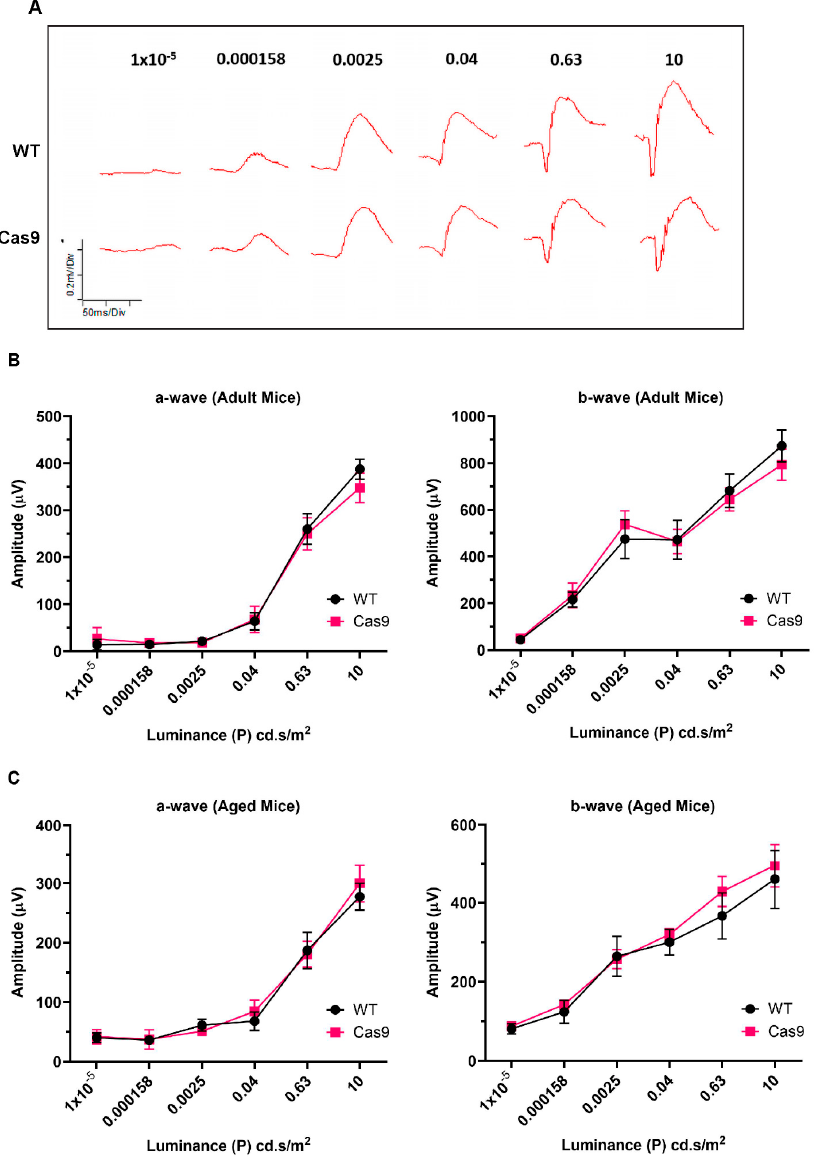
Figure 4. ERG analysis of retina function in Cas9 mice ( A ) Representative waveforms from ERGs of adult WT and Cas9 mice. ( B , C ) Scotopic a- and b-wave amplitudes, respectively, of adult and aged WT and Cas9 mice as a function of light intensity. Error bars represent SD (n = 6–8 per group). The a-wave and b-wave amplitudes at different flash intensities did not show any statistically significant (Mann–Whitney test; p -value < 0.01 considered significant) differences between age-matched WT (black) and Cas9 mice